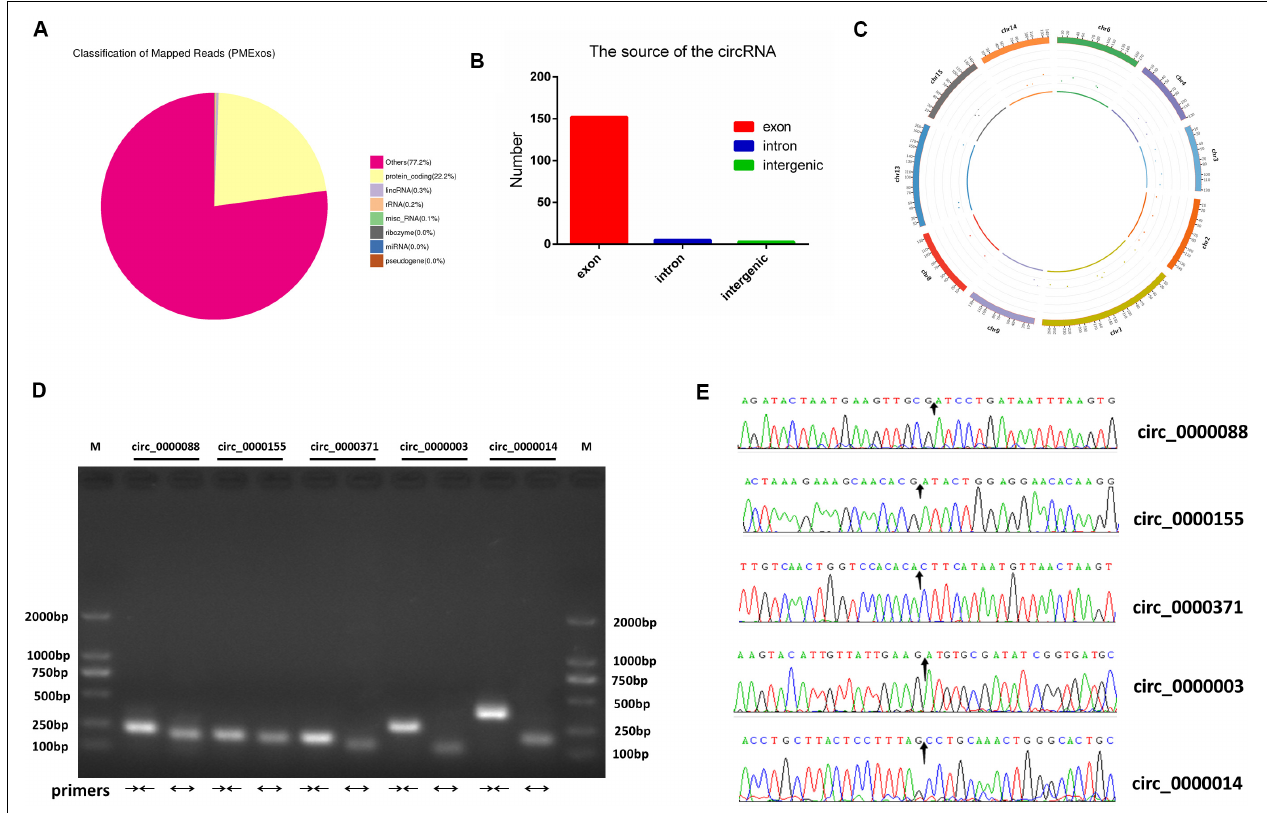
FIGURE 3 | Identification and characterization of circRNAs in porcine milk exosomes. (A) Distribution of sequencing reads in genes of known types. (B) The source of circRNAs. (C) The density distribution of circRNAs on chromosomes. (D) Identification of lncRNA PCR product size by agarose gel electrophoresis. M: marker (DL 2000); convergent primers ( →← ); divergent primers ( ←→ ); circ_0000088: (228 pb, 194 pb); circ_0000155: (198 pb, 184 pb); circ_0000371: (190 pb, 146 pb); circ_0000088: (269 pb, 111 pb); circ_0000014: (366 pb, 182 pb). (E) Head-to-tail splice junctions were confirmed using Sanger sequencing; the arrow points to the splice